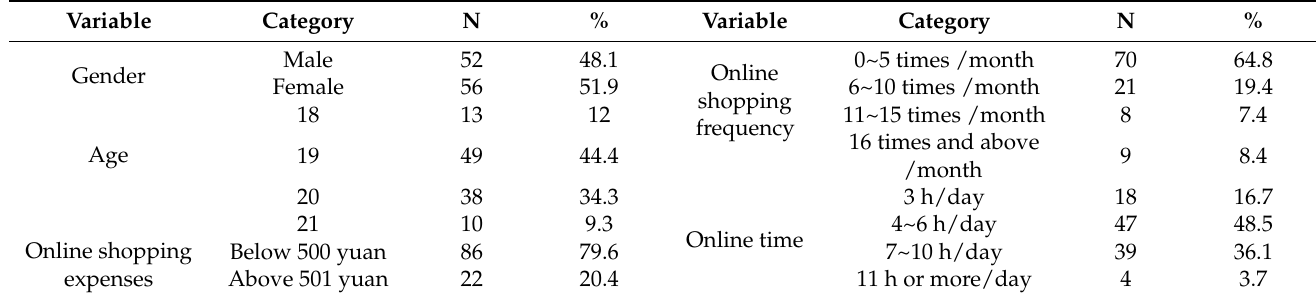
Table 5. Descriptive analysis of the